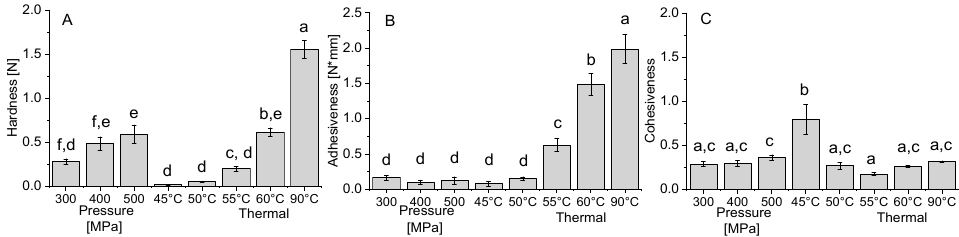
Figure 5. Texture profile analysis data of hardness ( A ), adhesiveness ( B ), and cohesiveness ( C ) of the heat and pressure induced gels at pH 3. Error bars represent standard deviation, different letters indicate significant differences ( p < 0.05, n = 6).